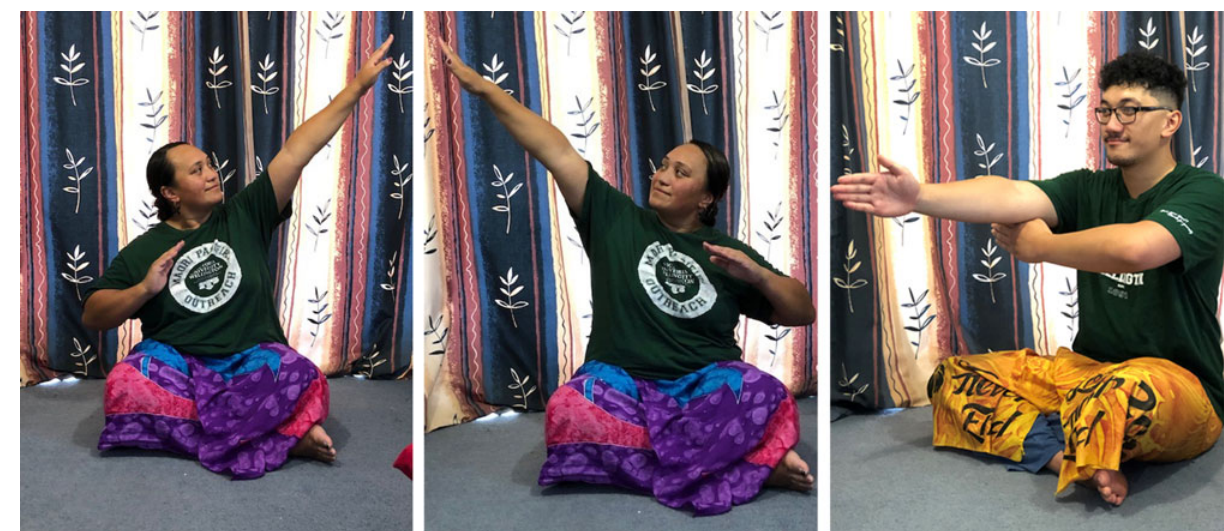
Fig. 4. Parallel and perpendicular